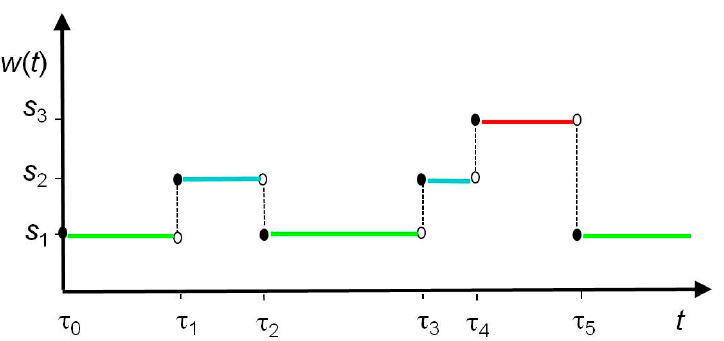
Figure 11. Example of the implementation of the process: { U ( t ) : t ∈ T } of a marine diesel main engine; (ME): { U ( t ) : t ∈ T } —process of state of repair; t —service life; s 1 —full effective operability